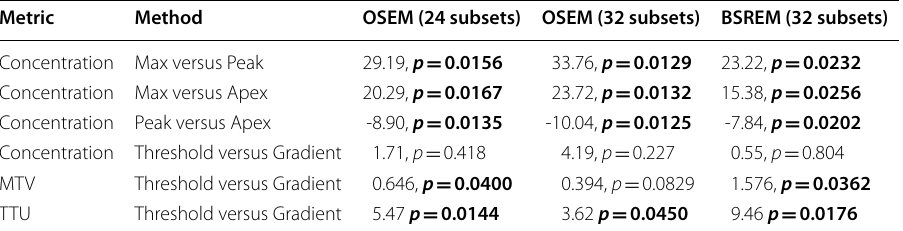
Table 3 Mean difference between methods for determining lesion activity concentration (kBq/mL), MTV (mL), and TTU (kBq)